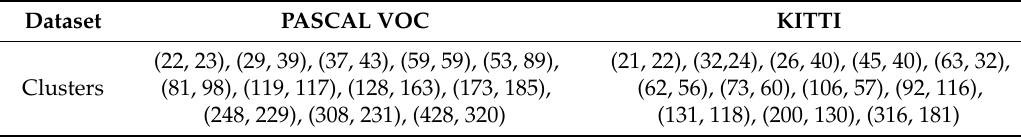
Table 1. The corresponding clusters on PASCAL VOC and KITII dataset.